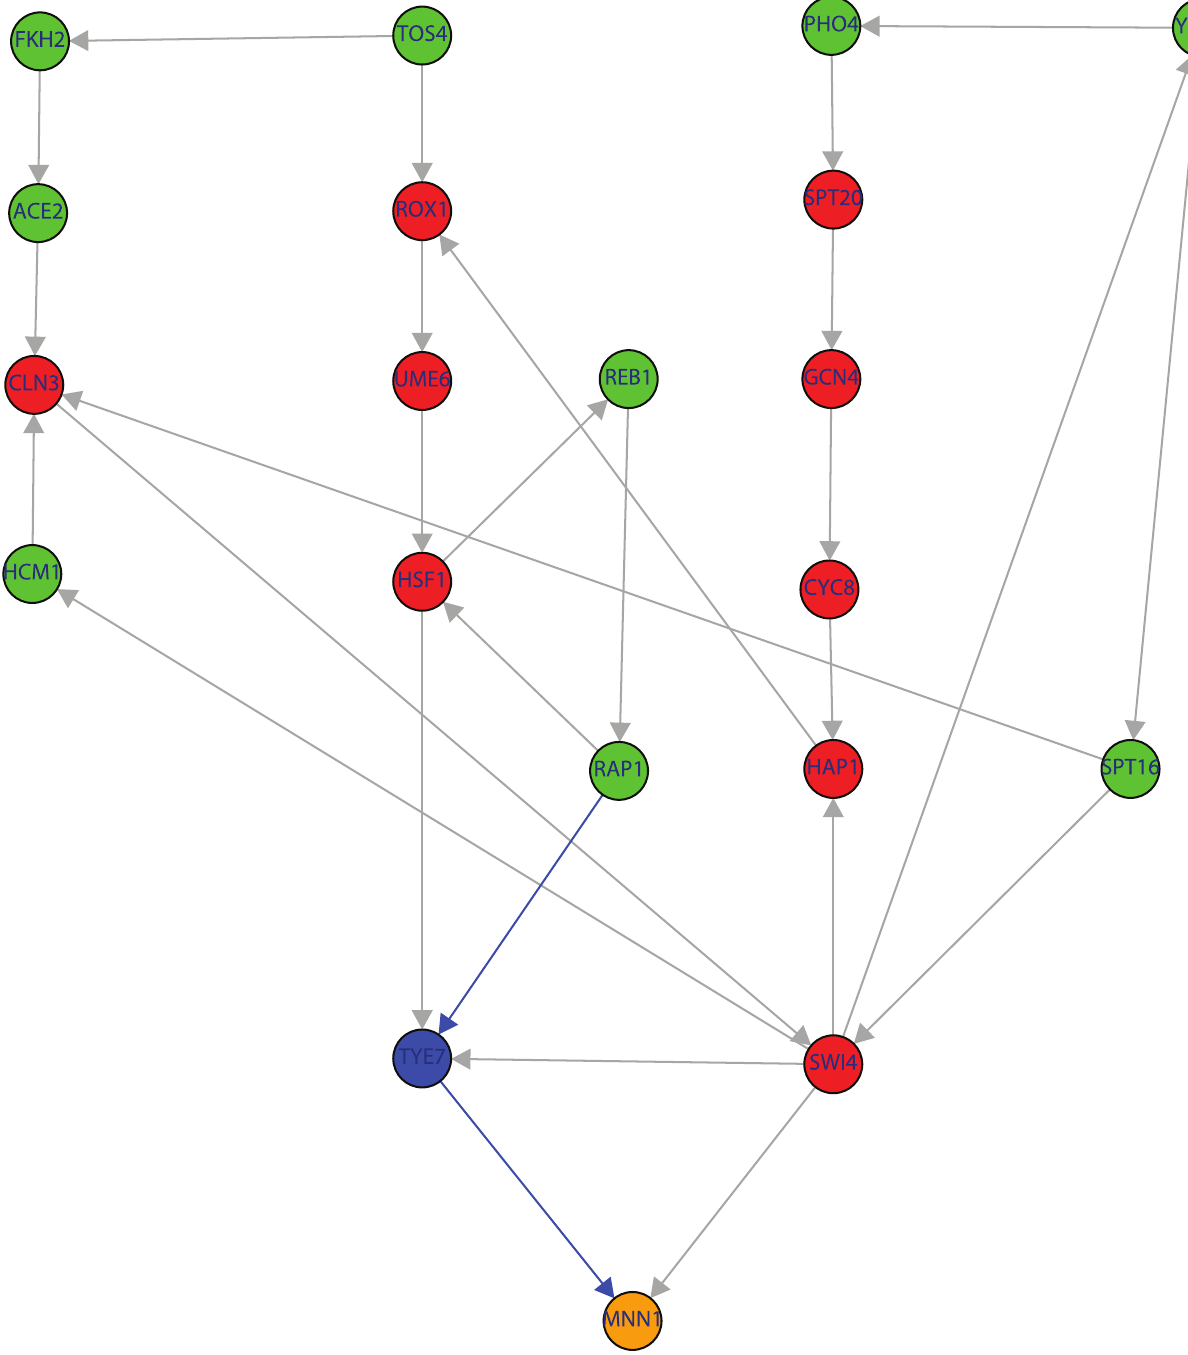
Figure 3. Subnetwork of the TRN consisting of 20 genes (color code as in Fig. 1). The shown subnetwork complements the results in table 1 by providing detailed information about the genes involved in the shortest paths. Blue edges indicate the shortest path connecting RAP1 R TYE7 R MNN1.